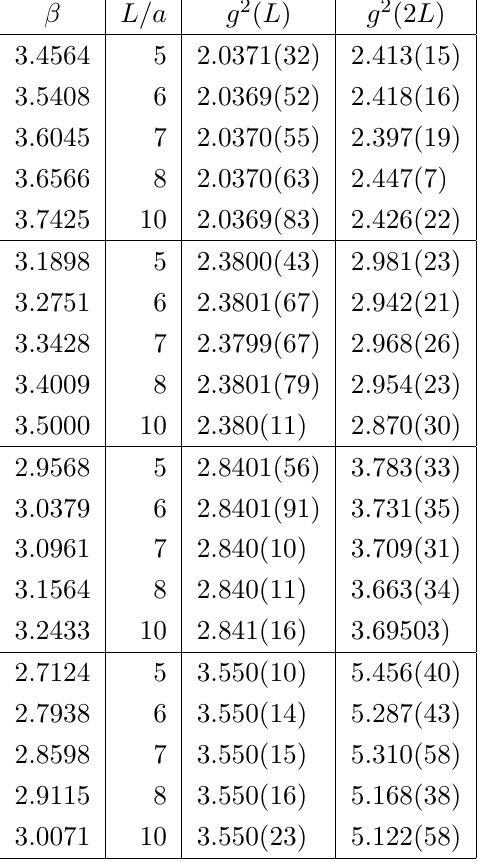
Table 4 . Results for pairs of running couplings at distances L and 2 L , at the same bare coupling (cid:12) = 4 =g 2 , reproduced from ref. [31, table 0